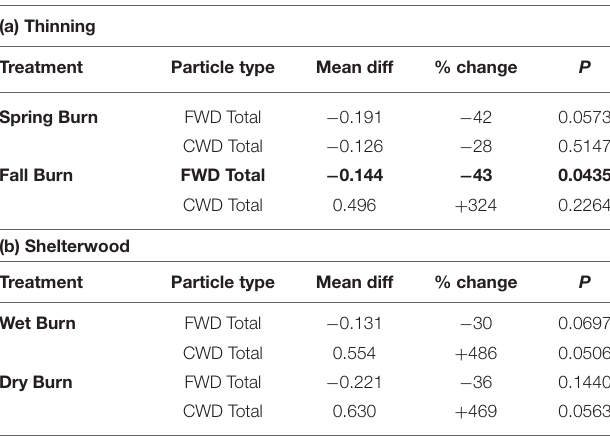
TABLE 1 | Changes in fuel loads (kg m − 2 ) from 1993/4 (post-treatment) to 2015 (22 years post-treatment) for (a) Thinning and (b) Retention Shelterwood. (a)